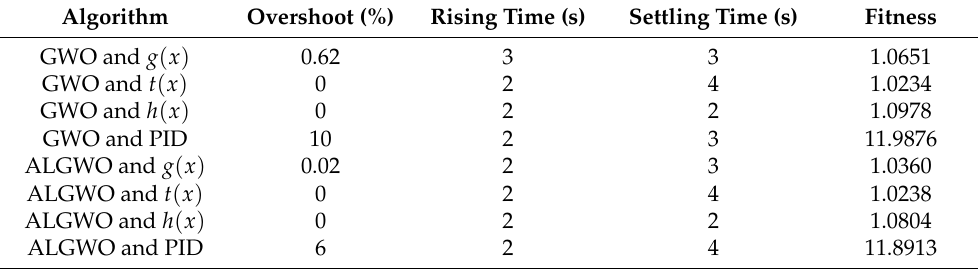
Table 7. Performance characteristics on test system 4.